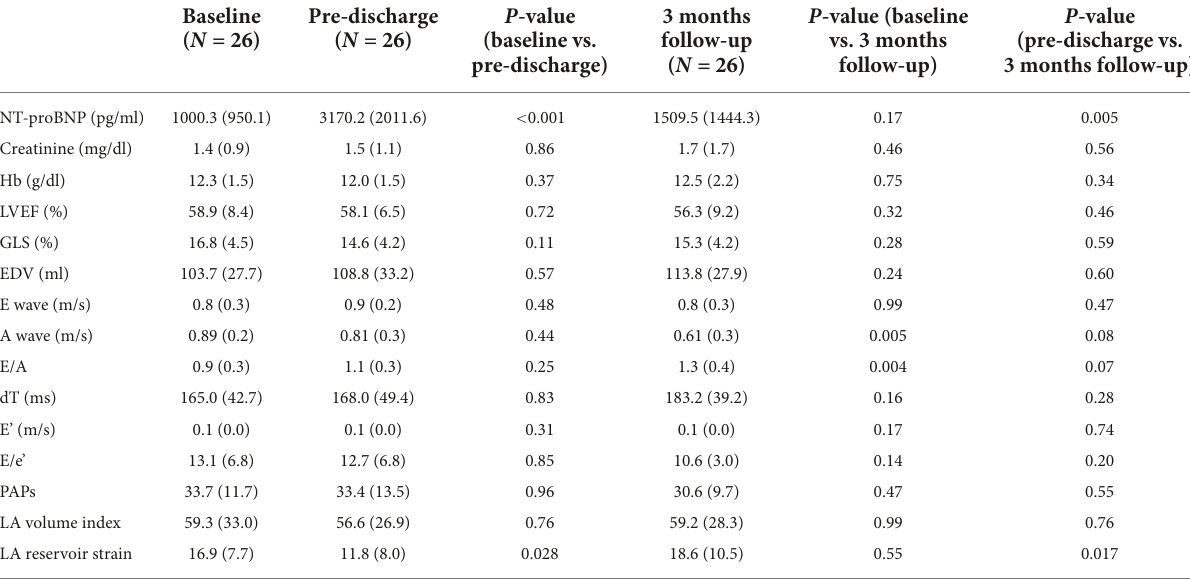
TABLE 2 Laboratory and echocardiographic data during follow-up.